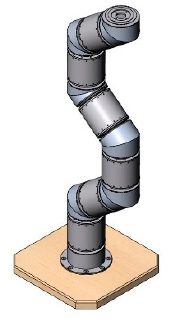
Figure 11. Model created in SolidWorks.